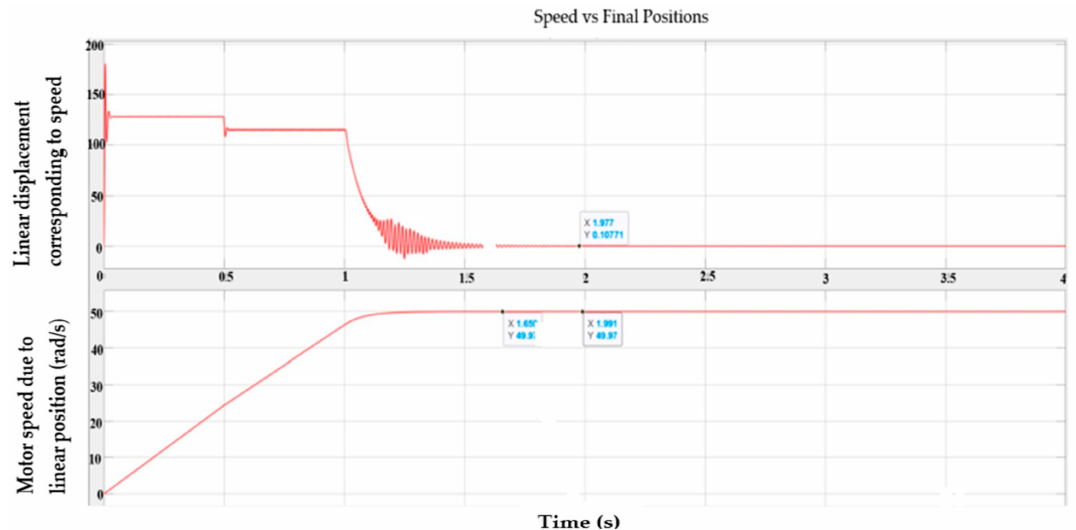
Figure 8. Motor and actuator response for a sudden load at 0.5 s, depicting speed and final position plots against time.